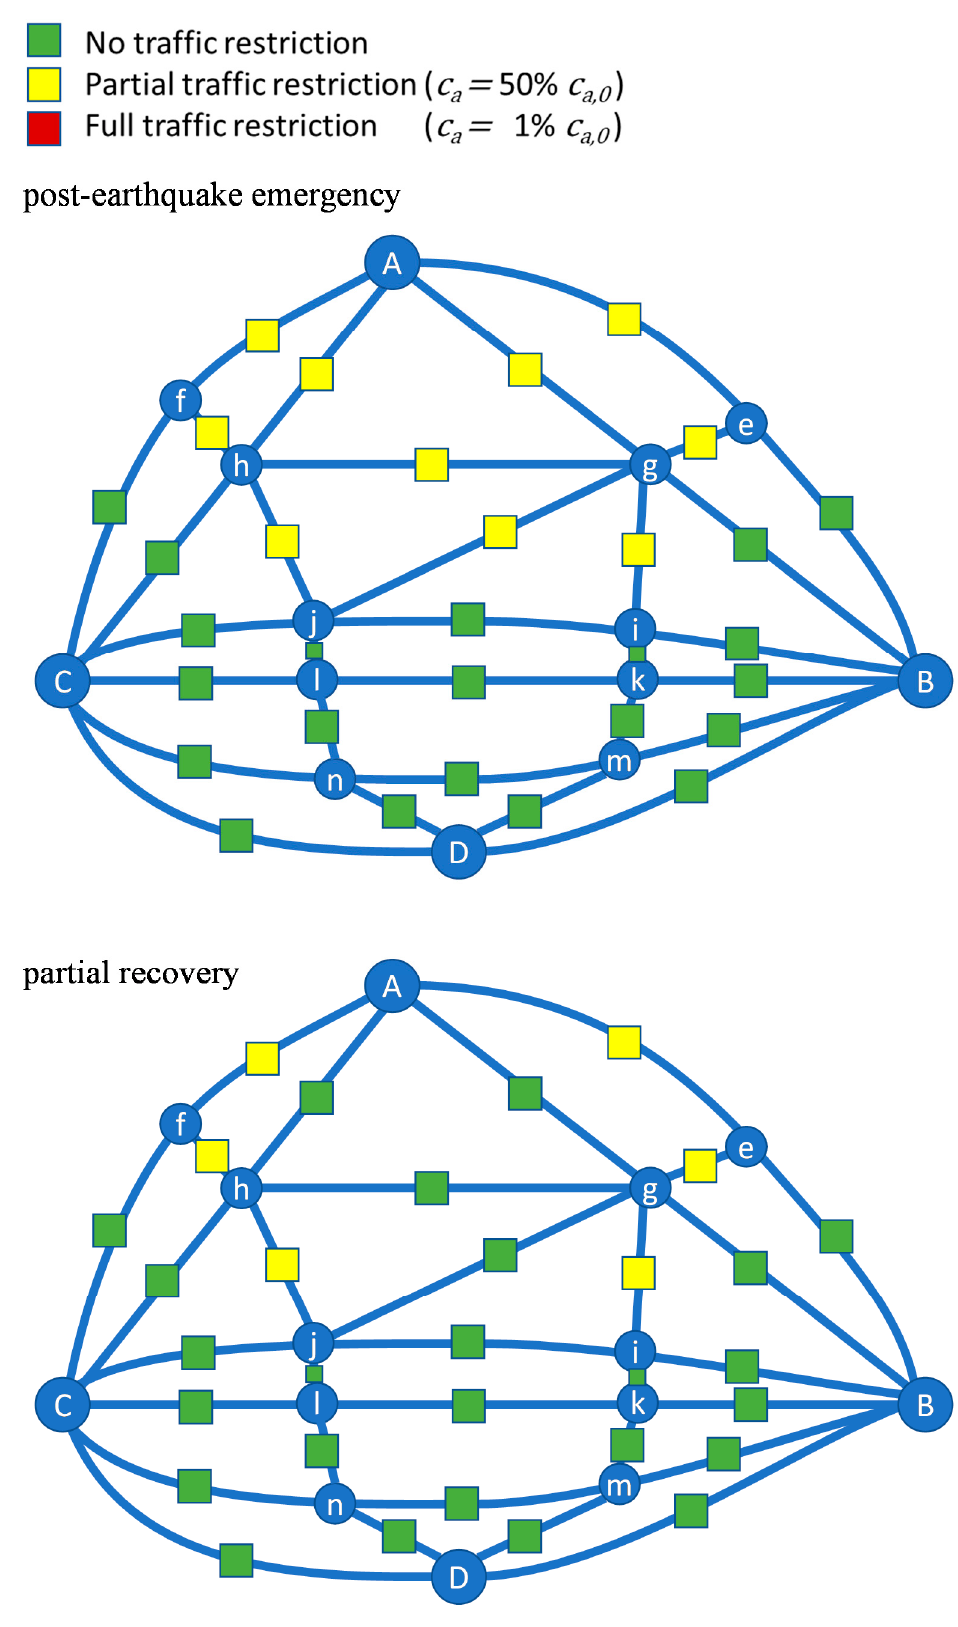
Figure 5. Post-Earthquake perturbations to link capacities c a .